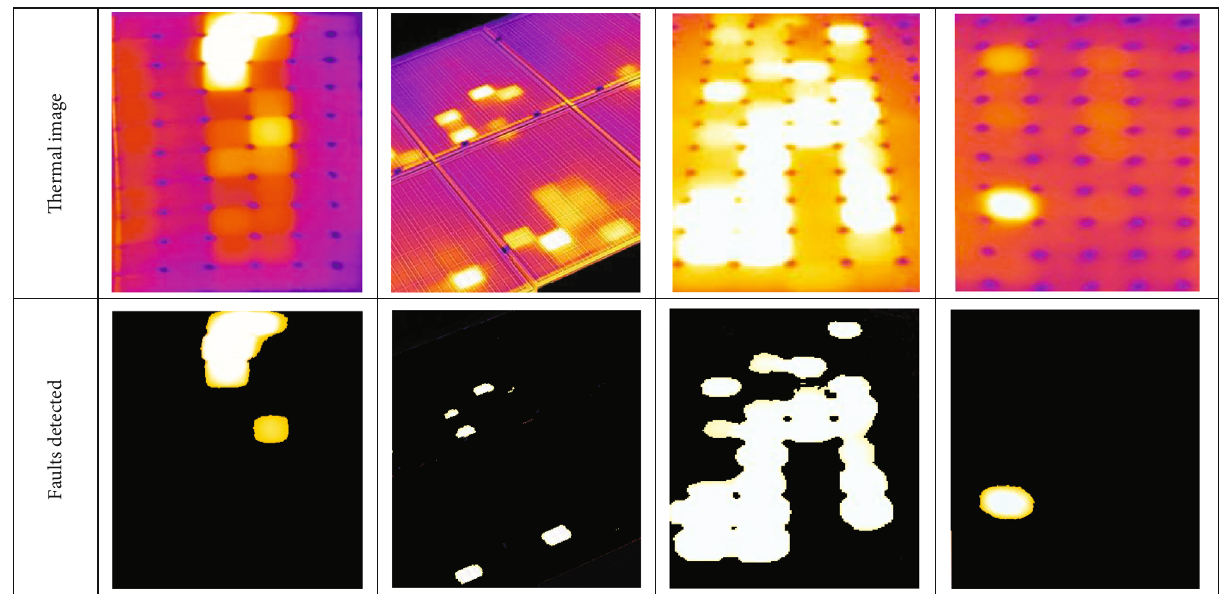
Figure 12: The application results of the K-means